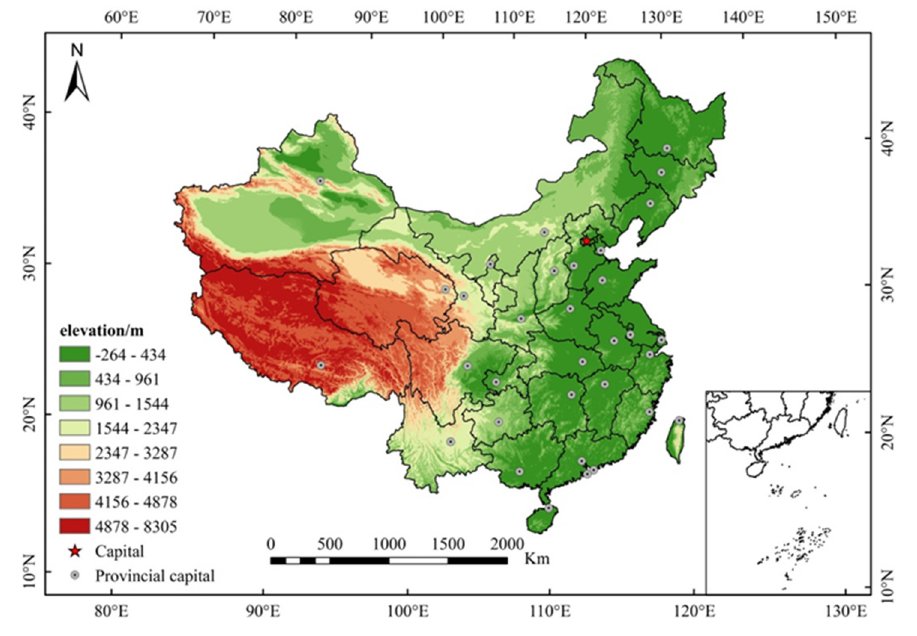
Figure 1. The elevation map of provinces in China.